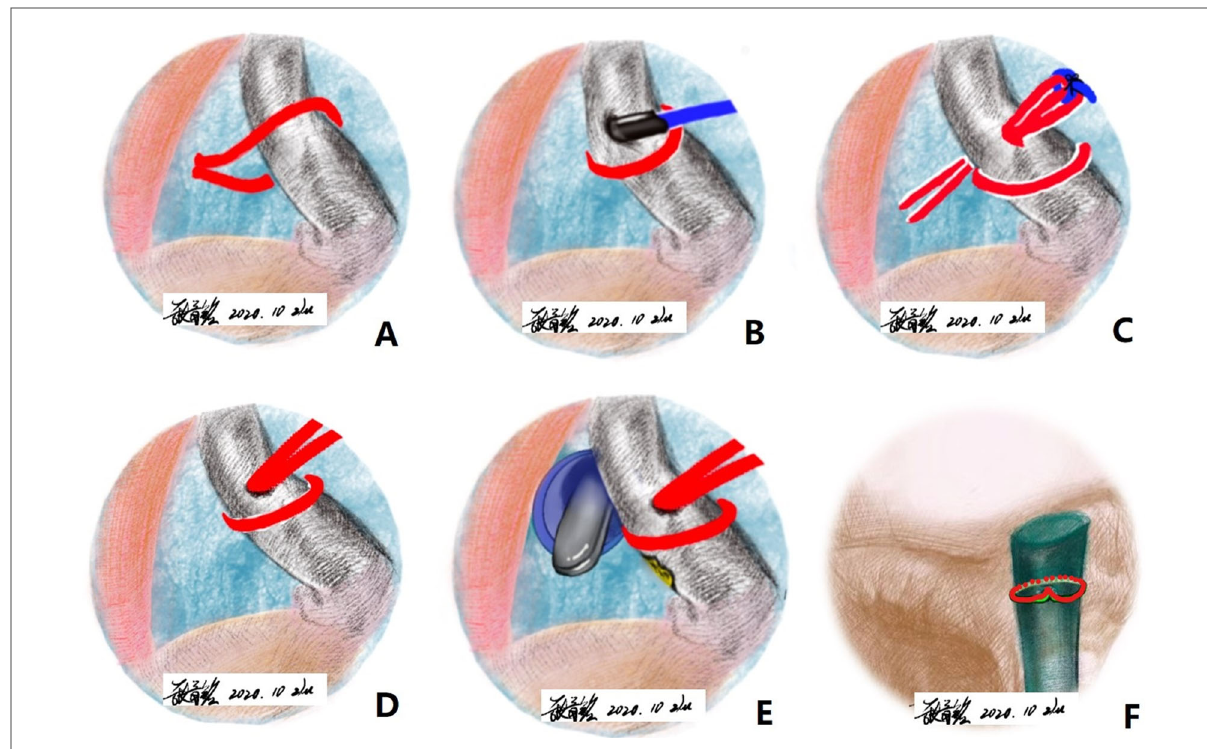
FIGURE 3 Illustrations summarizing the steps required to create H-LOOP tenodesis of